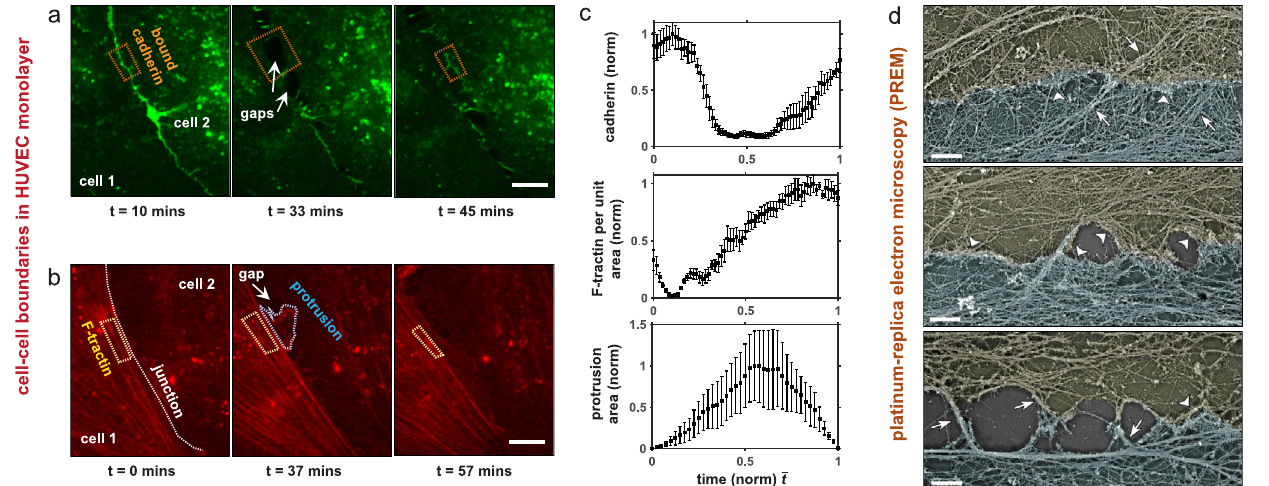
Fig.1|Remodelingofendothelialjunctions.a , b Dynamicsofgapformationand recovery inremodeling adherens junctions inHUVECSover time showing(a) GFP- VE-cadherinand( b )F-tractinhighlightingactinbundlesandactin-richprotrusions. Scale bars, 10 μ m ; ( c ) Local intensity of cadherin ( n =6 junctions), F-tractin ( n =4 junctions), and protrusion area ( n =4 junctions) along cell-boundaries (mean ± s.e.m.) in the vicinity of gaps (dashed outlines show examples of areas used for